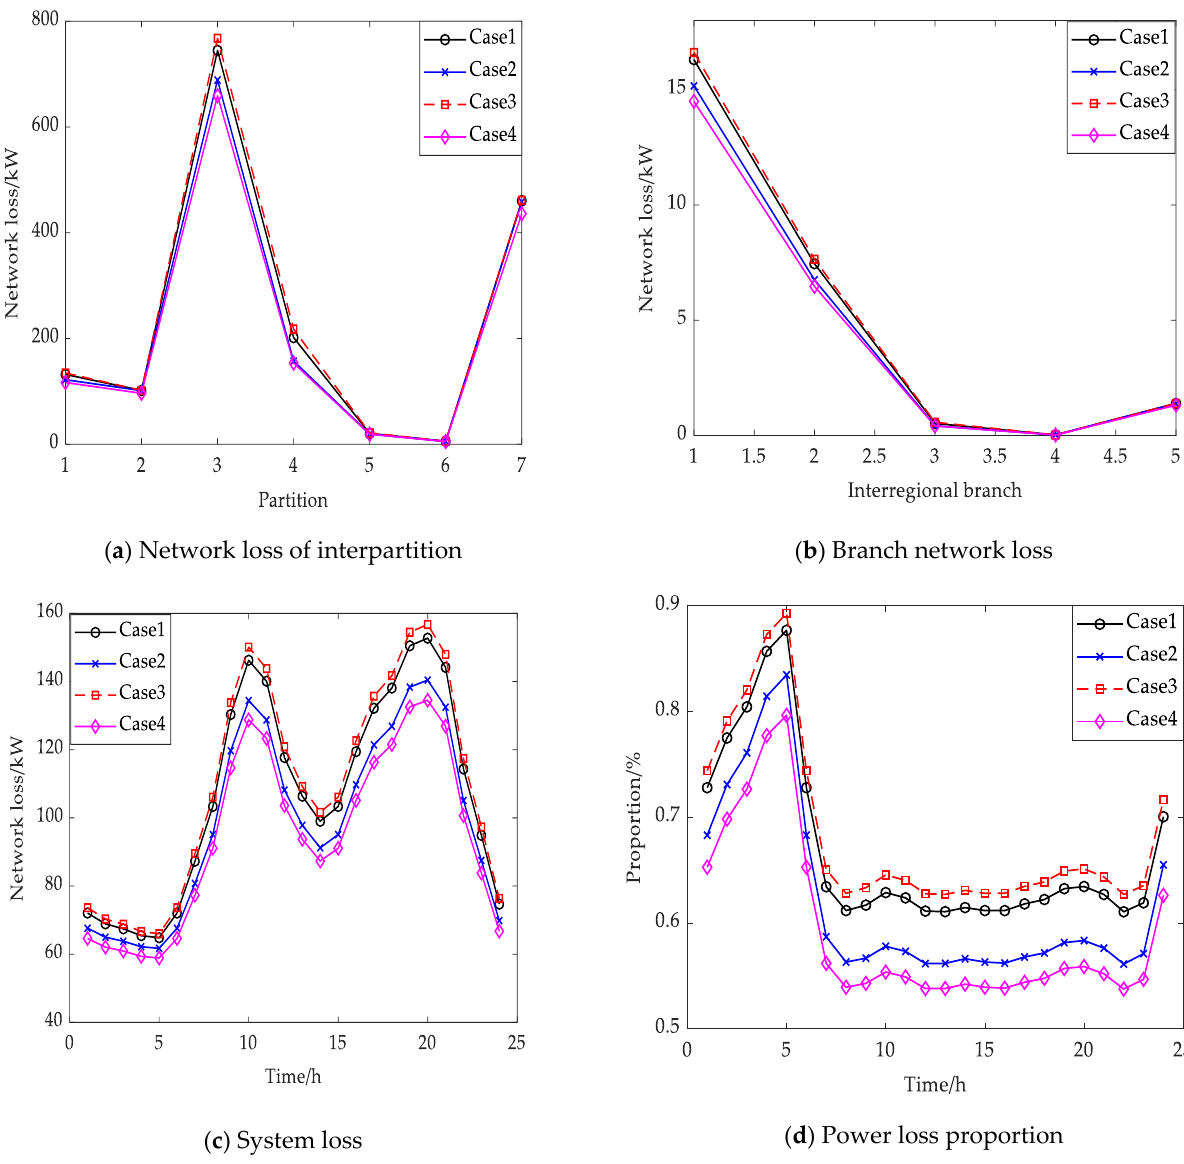
Figure 10. System loss Power loss proportion.